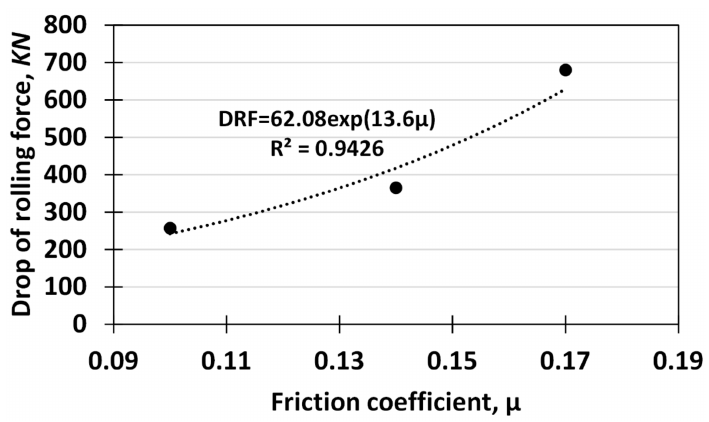
Figure 15. Dependence of DRF on the friction coefficient during downward